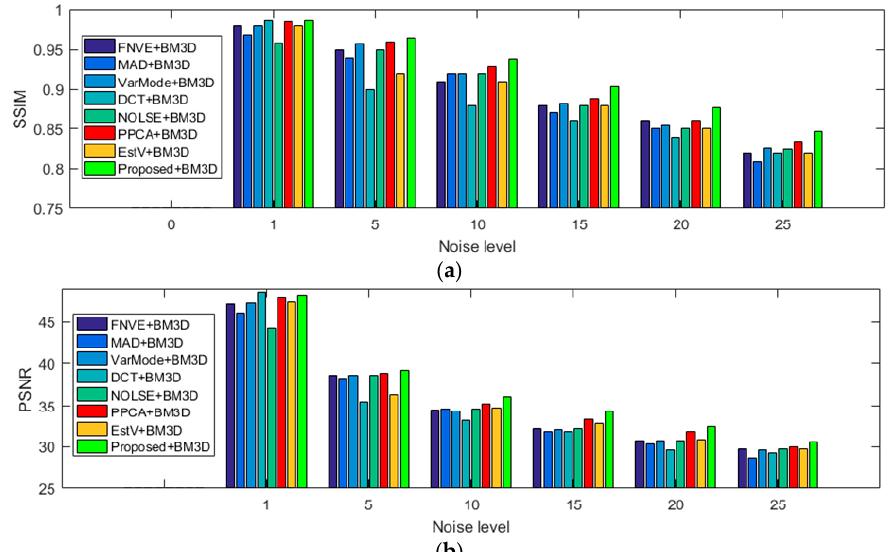
Figure 11. Structural similarity index measurement (SSIM) and peak signal-to-noise ratio (PSNR) comparison results of different AWGN estimators with BM3D for blind de-noising on the 134 selected images at different noise levels. ( a ) Comparison results of SSIM; ( b ) comparison results of PSNR.